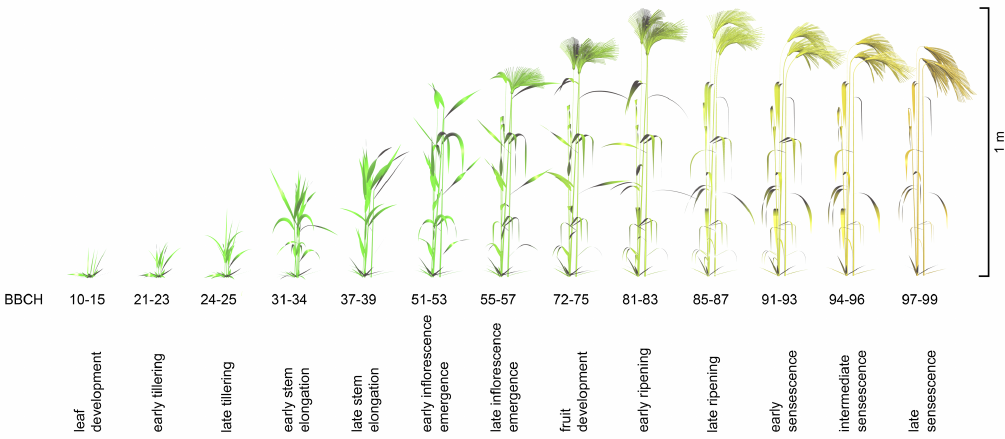
Figure 1. Modelled phenology stages of winter barley and their corresponding BBCH stages. The colours are chosen to visually support the phenological development. They do not correspond to any spectral